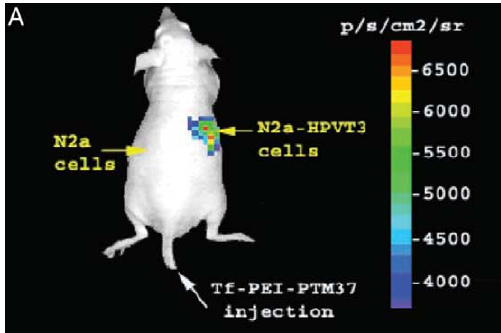
Fig. 5. Bioluminescent imaging following subcutaneous implanta- tion with Renilla luciferase (N2a LucHPVT3) transfected cells (right side) or mock N2a transfected cells (left side) in a nude mouse. The tumour site expressing luciferase emitted a bioluminescent sig- nal which was amplified through administration of * SMaRT probe (Tf-PEI-PTM37) 24 h prior to injection with the substrate coelenter- azine [6]. Spliceosome-mediated RNA trans-splicing